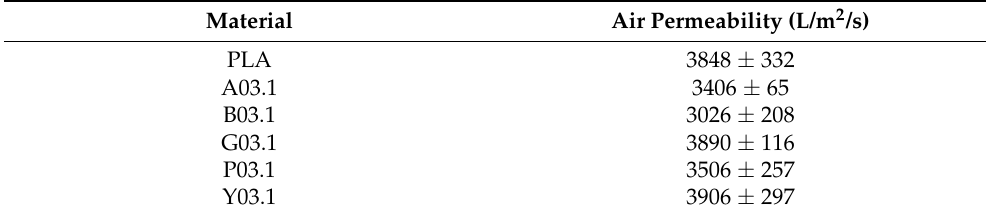
Table 7. Absolute air permeability of knitted fabrics made from PLA and dyed PLA yarns containing 0.3% ( w / w ) of each colorant. Data are means ± SD ( n =